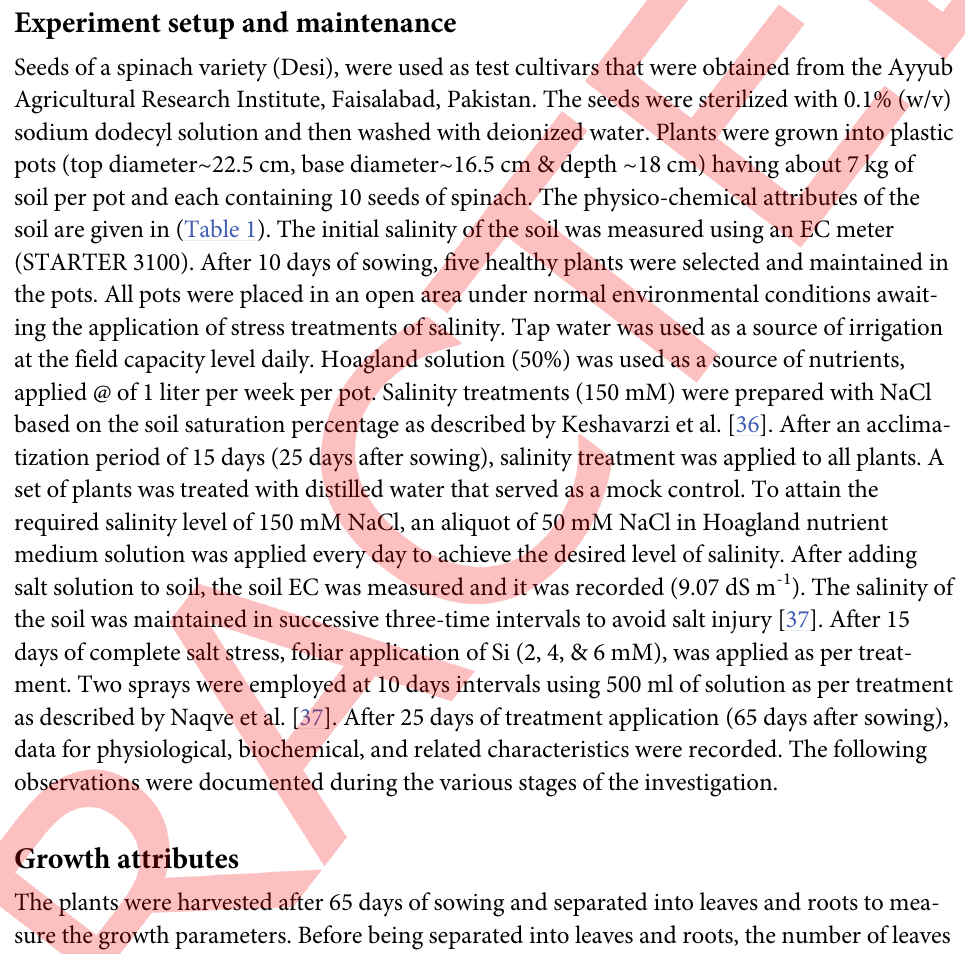
Table 1. Basic physico-chemical attributes of experimental